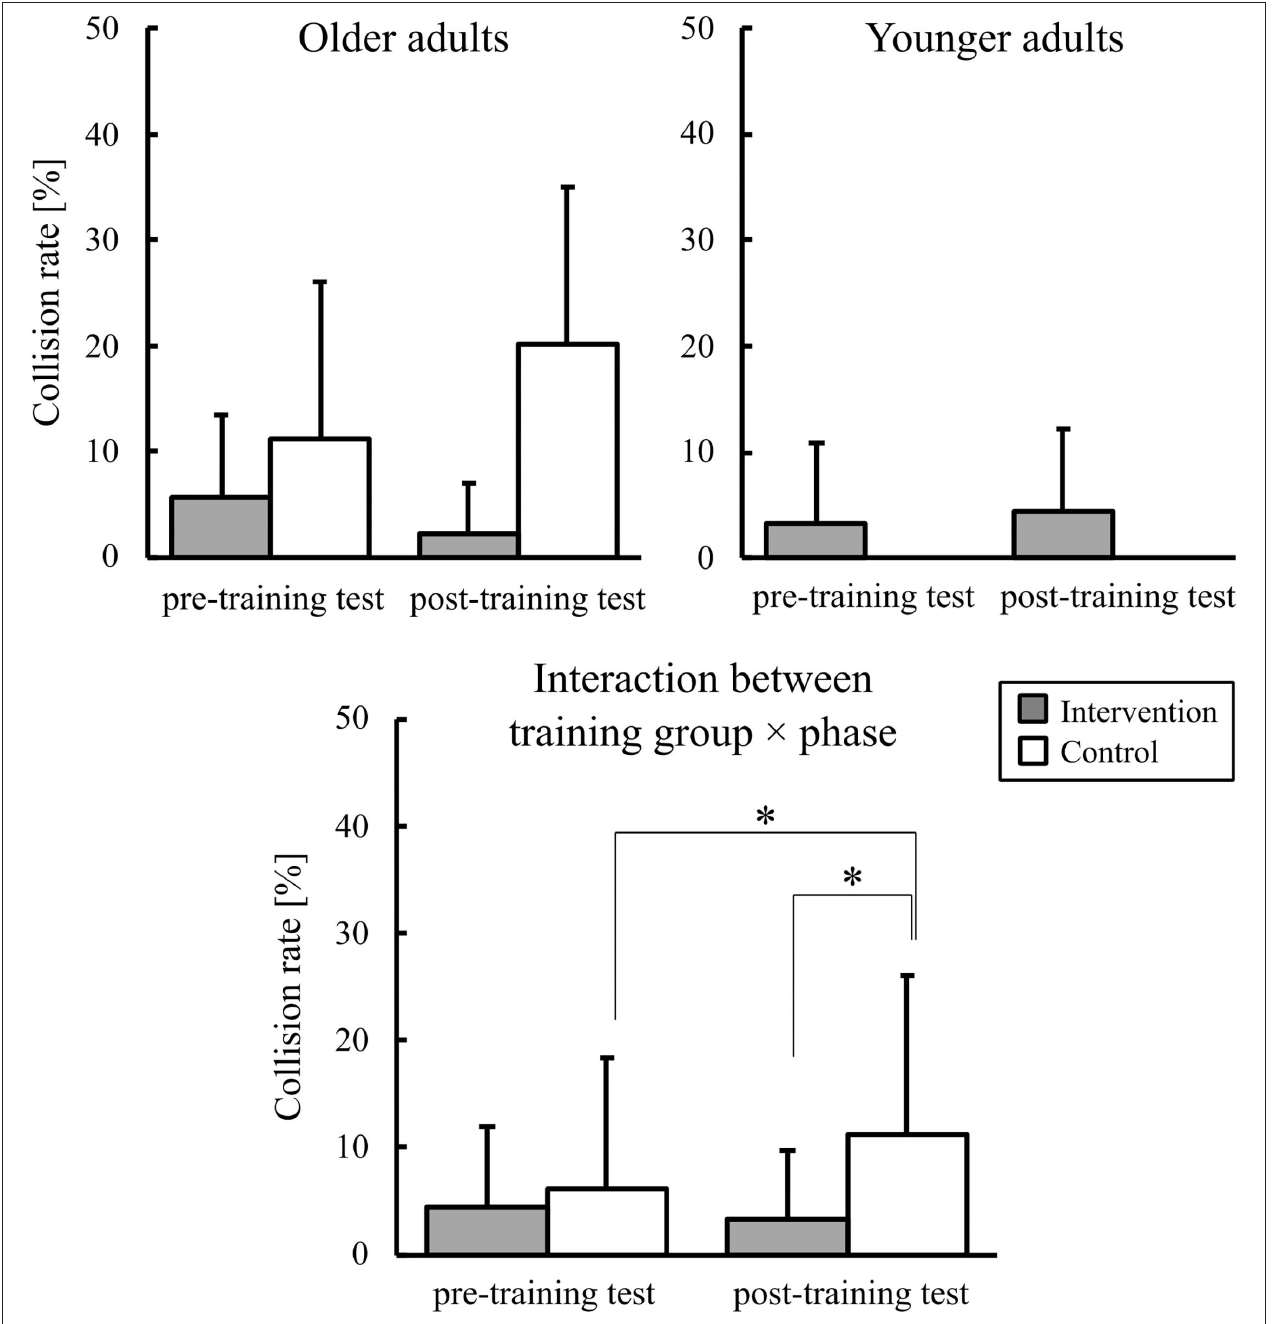
FIGURE 5 | Graphs of the collision rate. Error bars represent the standard deviation among participants. * indicates the significant